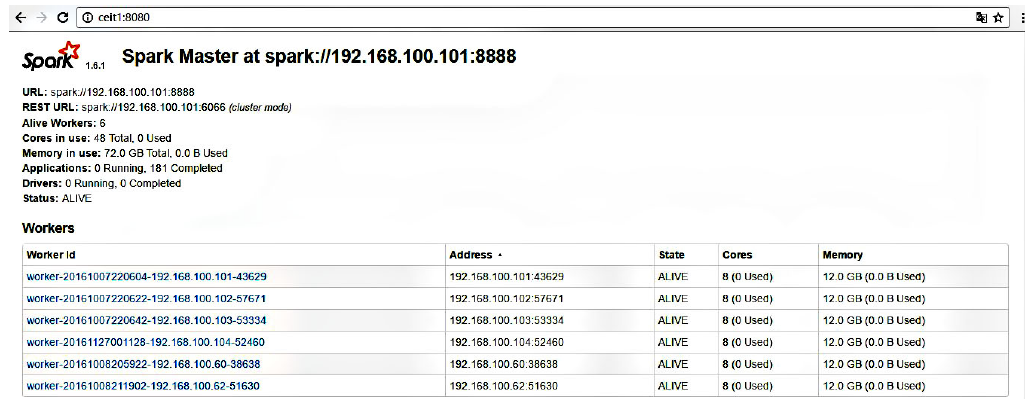
Figure 5. Monitoring interface of our platform.